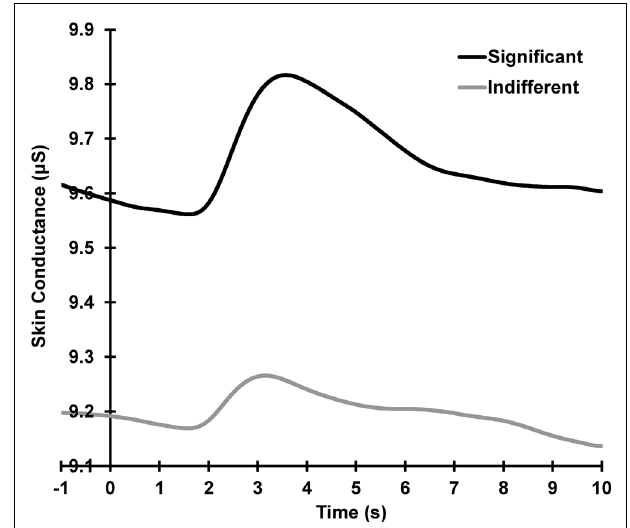
FIGURE 2 | Grand mean SCRs across all trials, separately for each condition. Activity shown is prior to linear de-trending to remove the falling